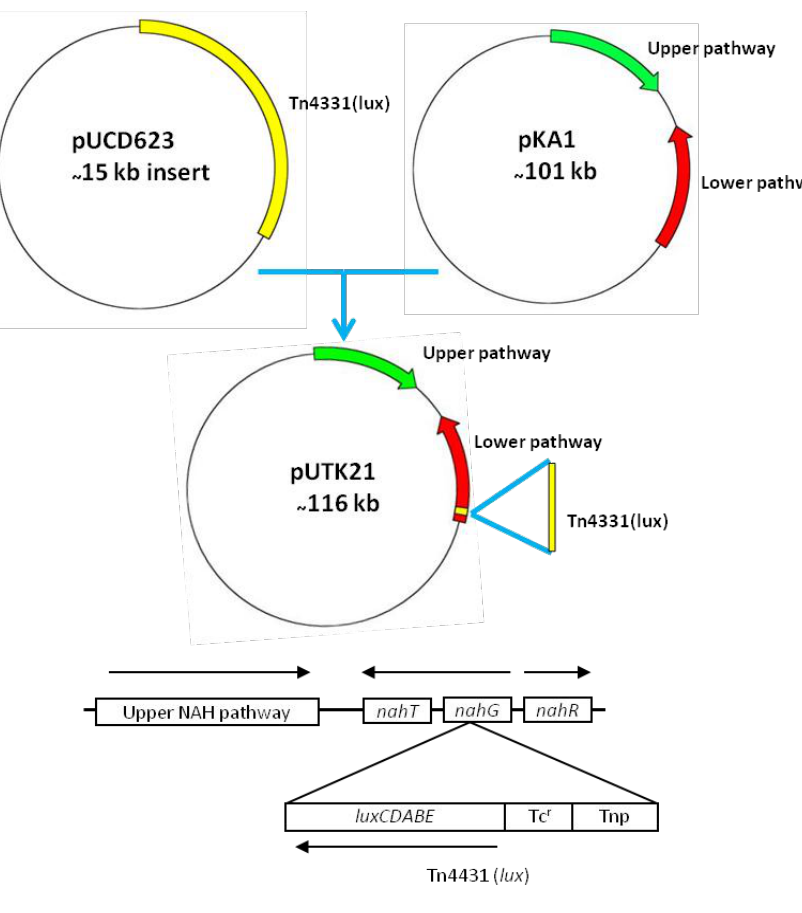
Figure 3. Plasmid pUTK21 contains a transposon-based luxCDABE insert positioned within the nahG gene. This permits direct observation of naphthalene catabolic activity via emission and real-time measurement of bioluminescence. Tc r , tetracycline resistance gene; Tnp, transposase.